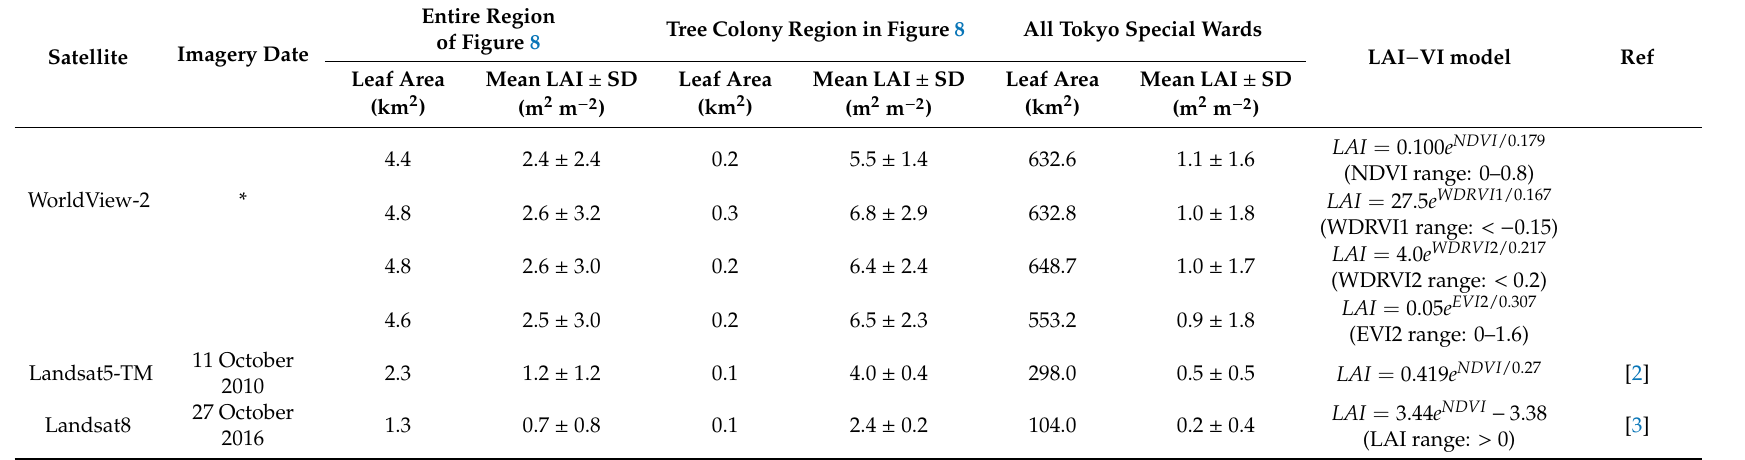
Table 5. Comparison of the total tree canopy leaf area (km 2 ) estimated in Figure 8 and all Tokyo special wards from the satellite images (WorldView-2 / 3, Landsat5-TM, and Landsat8) and the respective LAI − VI